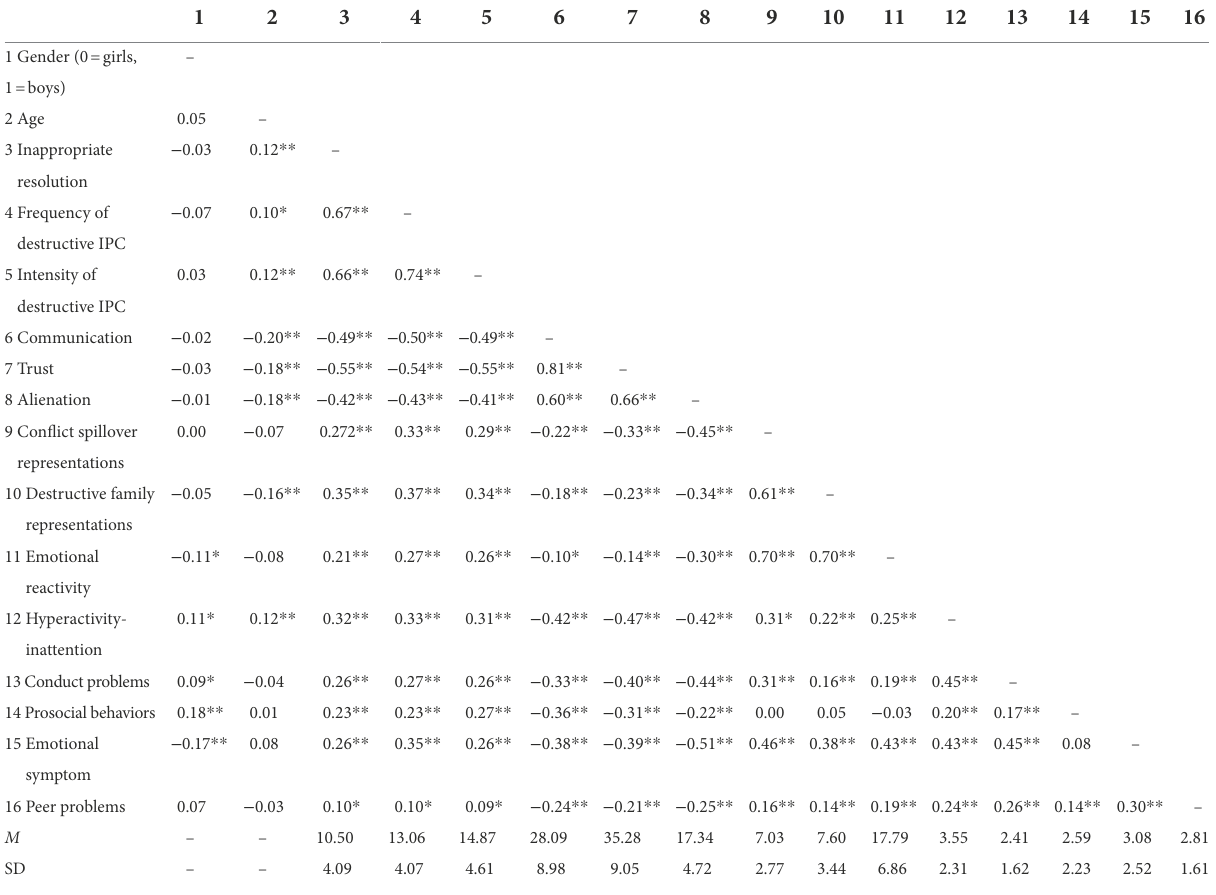
TABLE 1 Zero-order correlations and descriptive for study